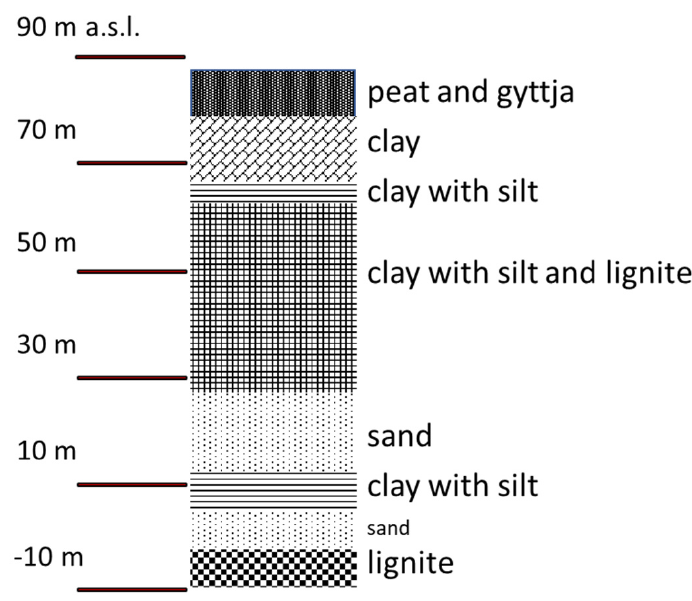
Figure 1. Stratigraphic column of Nienawiszcz reservoir before peat excavation.